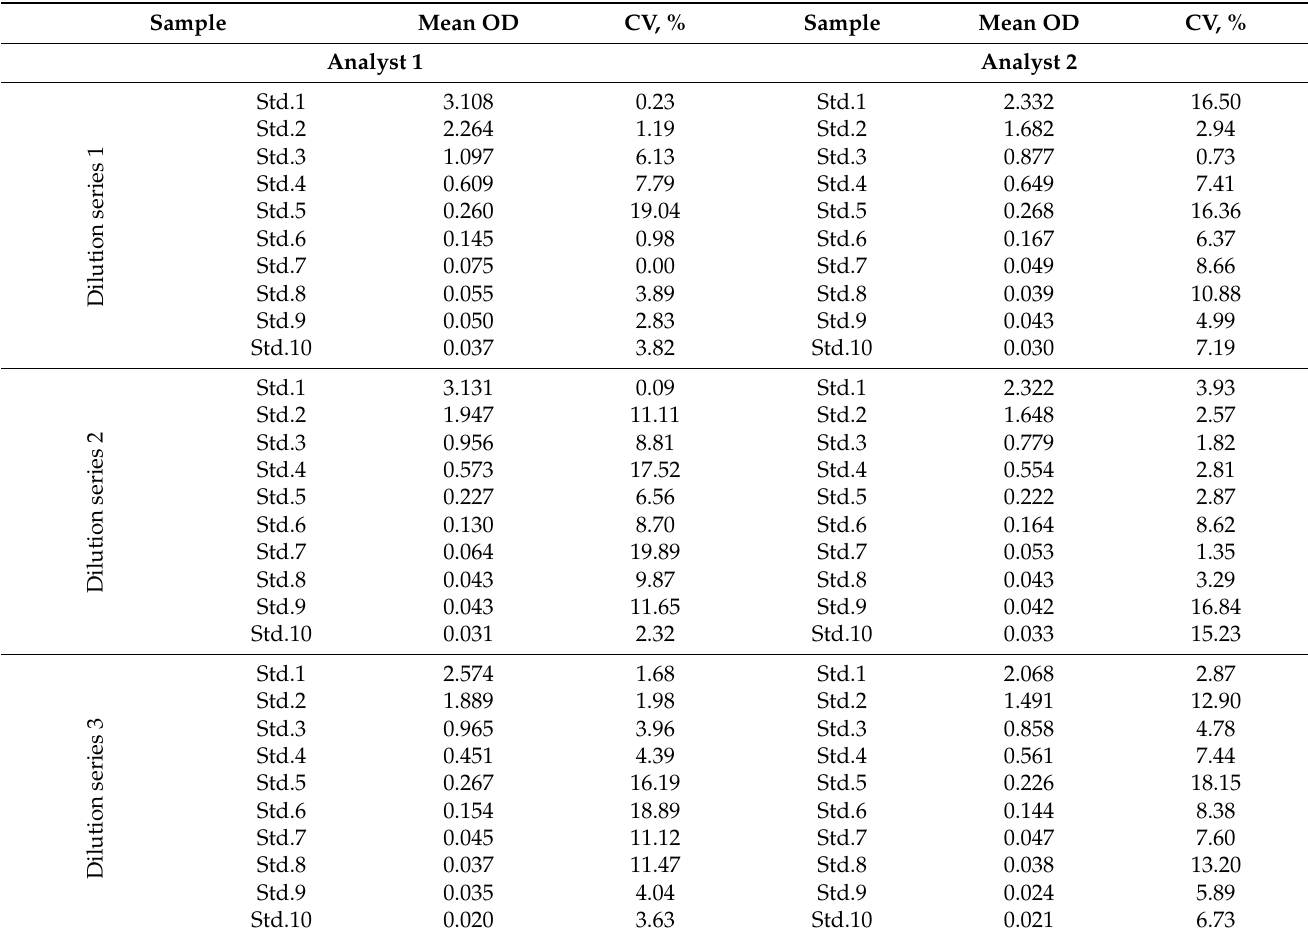
Table 3. Mean OD values obtained during method sensitivity